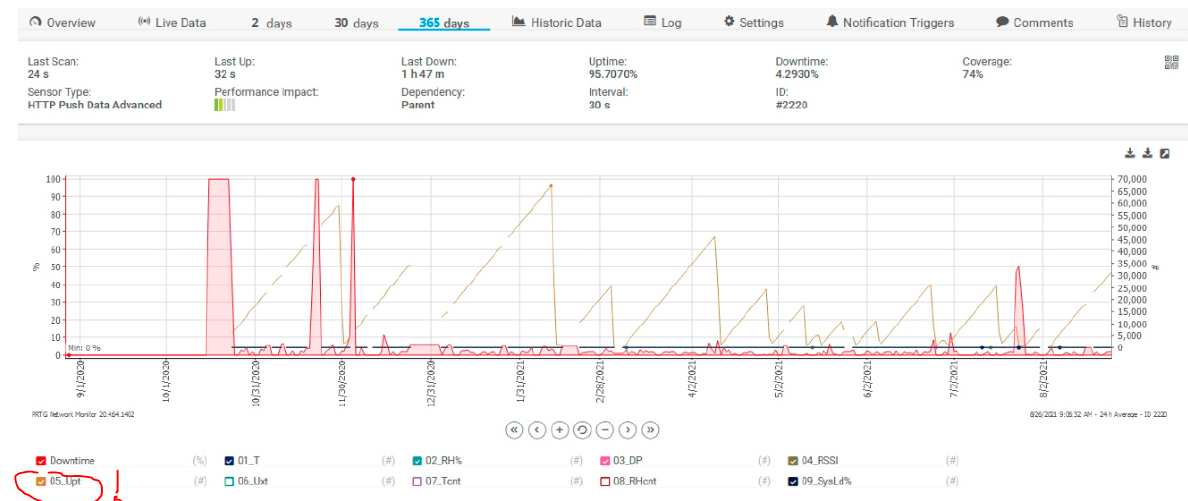
Figure 16. Microclimate monitoring in LV/MV switchgear using PRTG Server—365 days filter, Sensor UpTime filter checked, name 05_Upt.